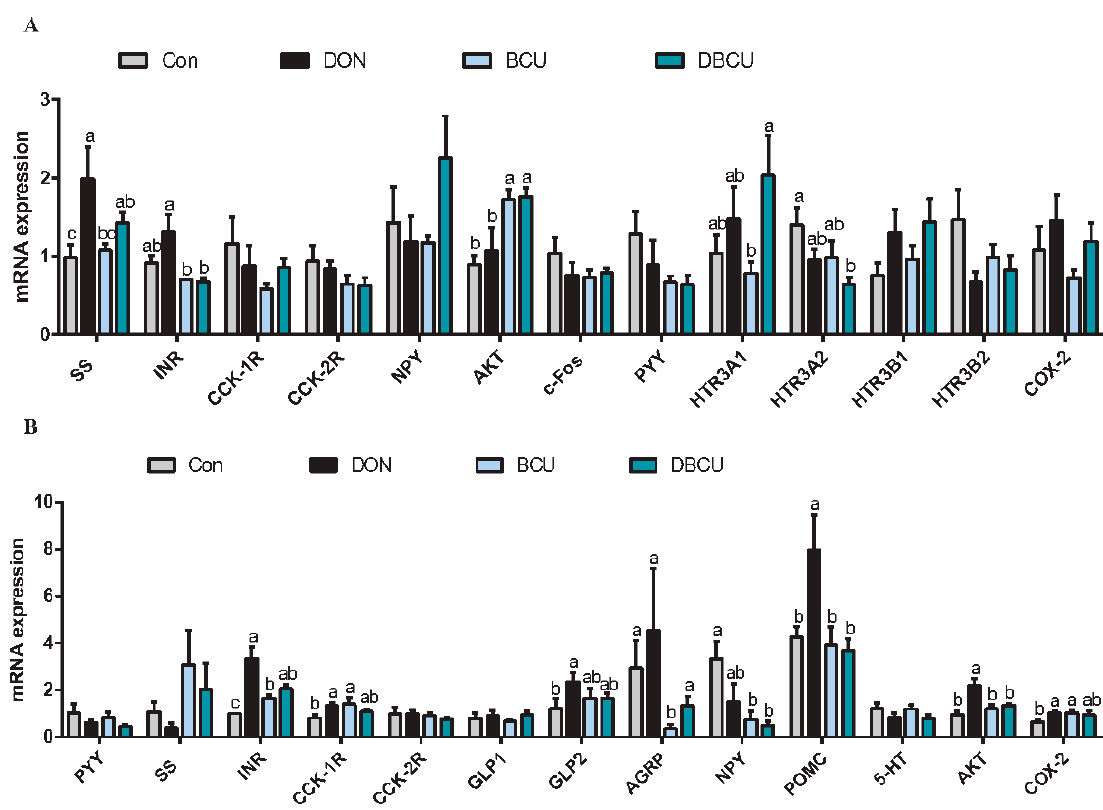
Figure 6. Effects of dietary DON and BCU on mRNA expression in the hypothalamus and pituitary of piglets. ( A ) Hypothalamus. ( B ) Pituitary. Values are means ± SEMs, n = 7. Different letters in the picture represent differences, p < 0.05. Basal diet (Con); 4 mg DON/kg diet (DON); 5 g BCU/kg diet (BCU); 5 g BCU/kg with 4 mg DON/kg diet (DBCU). PYY: peptide tyrosine; SS: somatostatin; c-Fos: Fos proto-oncogene, AP-1 transcription factor subunit; GLP-1R: glucagon like peptide 1 receptor; CCK-1R: cholecystokinin type A receptor; INR: insulin receptor; GLP-2R: glucagon like peptide 2 receptor; CCK-2R: cholecystokinin B receptor; AGRP: agouti-related protein; NPY: neuropeptide Y; COX-2: cyclooxygenase-2 (also known as prostaglandin-endoperoxide synthase 2 (PTGS2)); POMC: pro-opiomelanocortin; AKT: AKT serine/threonine kinase 1 (AKT1), transcript variant X3; HTR3A: 5-hydroxytryptamine receptor 3A; HTR3B: 5-hydroxytryptamine receptor 3B.